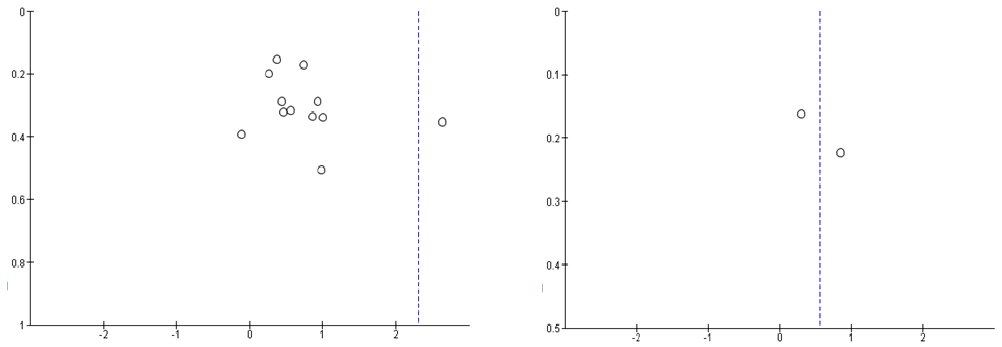
Figure 4. Meta-analysis of mindfulness in the workplace and influence on stress (online intervention).